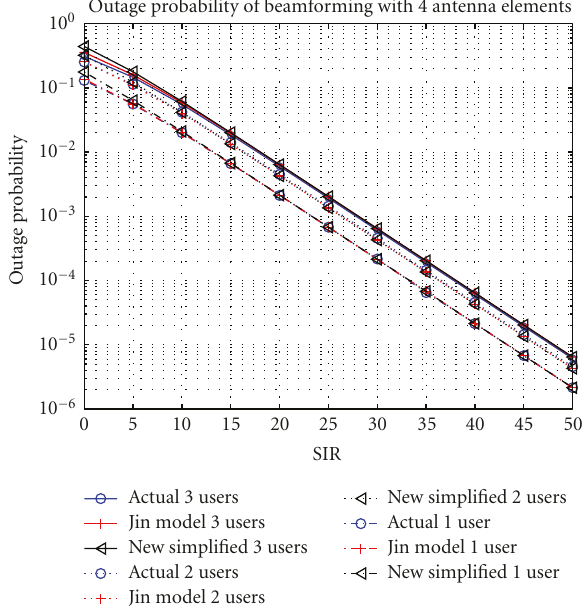
Figure 4: Accuracy of the new simplified beamforming model compared with Jin’s model and exact result. The number of antenna elements M = 4. plotted. The accuracy of the simplified beamforming